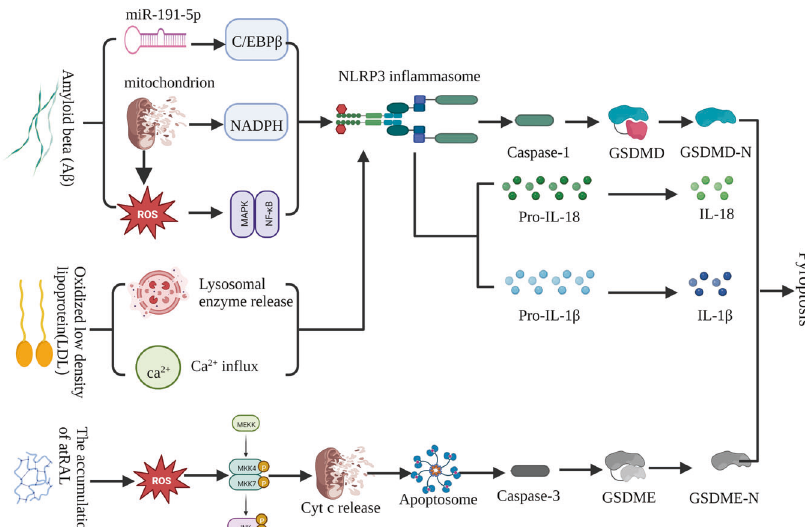
Fig. 4 Pyroptosis and AMD: Amyloid beta and low-density lipoprotein can activate the classical pyroptotic pathway. The accumulation of atRAL can activate the caspase-3-dependent pyroptotic